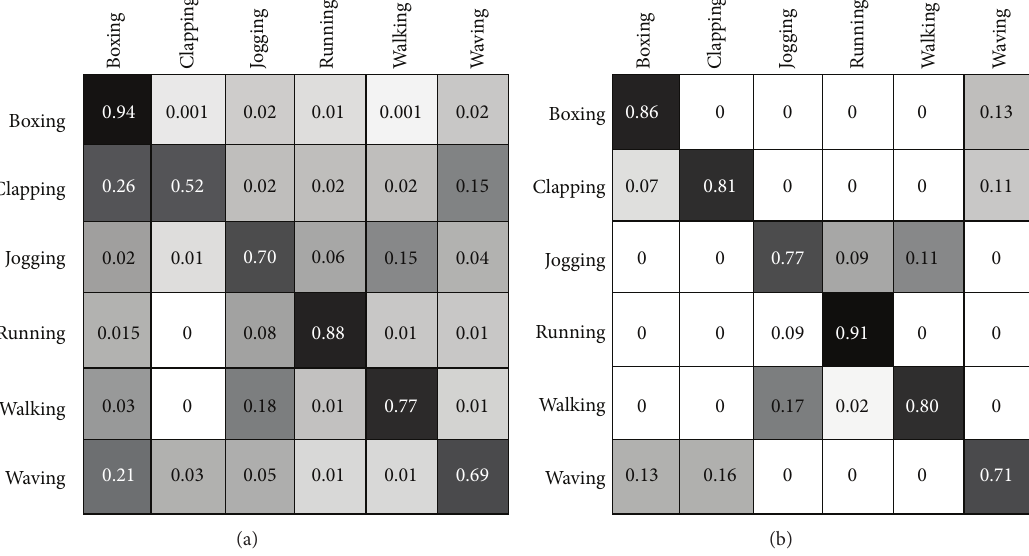
Figure 6: Confusion matrices SNN classifying KTH dataset obtained by adapted active basis model as combination of form and motion pathways. Confusion matrices of the proposed approach has been presented for the case of without fuzzy interference system, left matrix, and after it, right matrix which are achieved from human action movements of KTH dataset [39]. The robustness of the method after adding the fuzzy interference stabilizer is considerably increased. The wrong recognitions in the left confusion matrix have been decreased especially in case of some actions, that is, clapping. Moreover, soar of robustness helps to increase the overall accuracy and better results in classification of biological movement. The accuracy of categorizations using unbalanced SNN reached 86.46%.